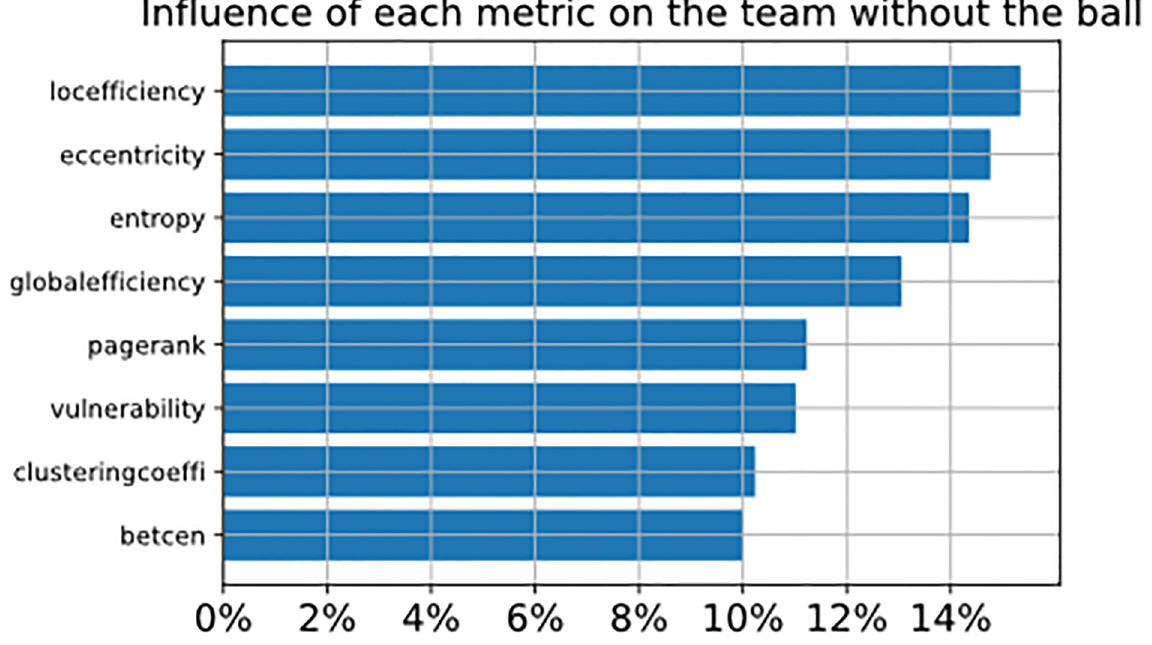
Fig 12. The figure shows the SHAP values of metrics of the attacking team.